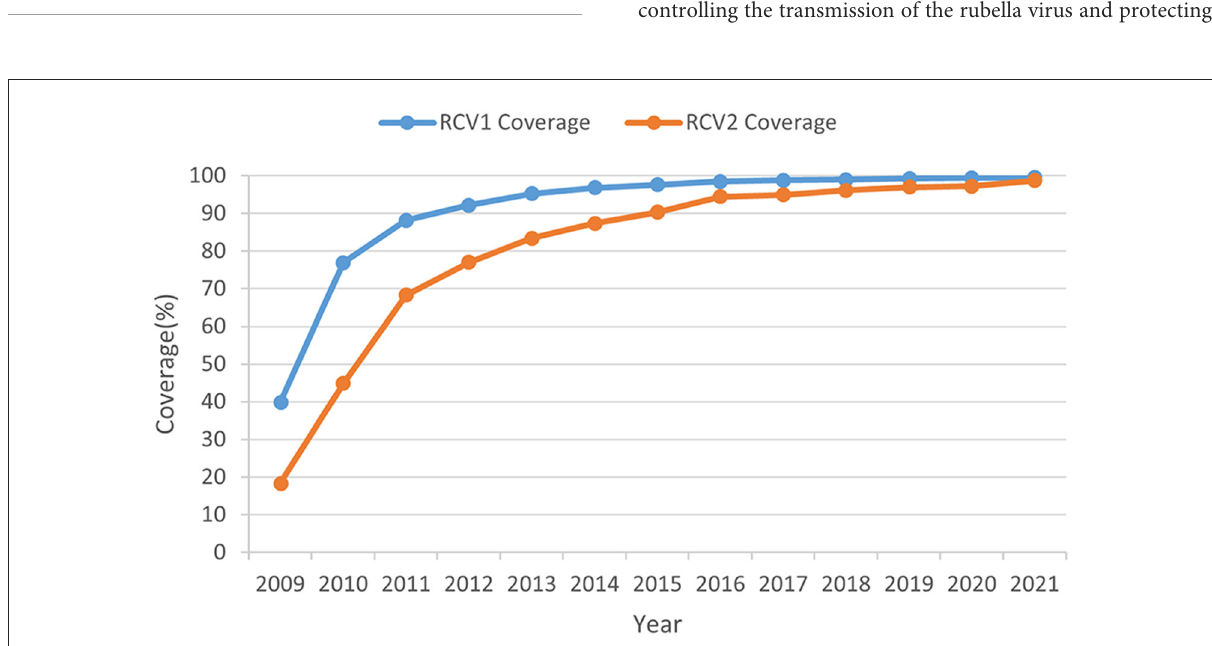
FIGURE4 Reported RCV coverage levels in routine immunization from 2012 to